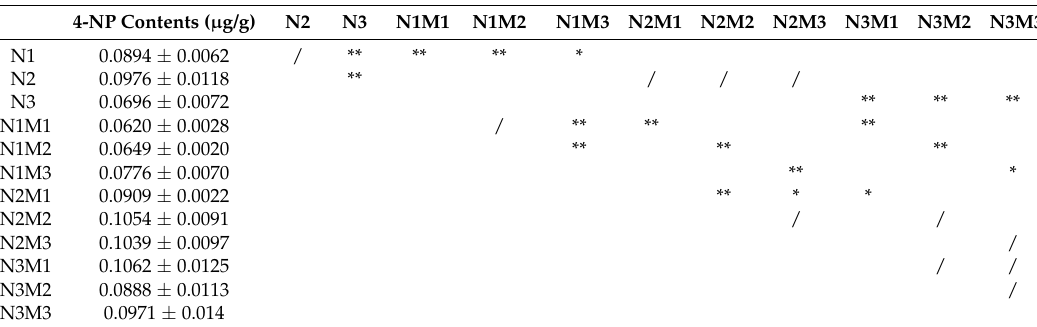
Table 7. Statistical analysis of 4-NP contents in muscle at Day 15.